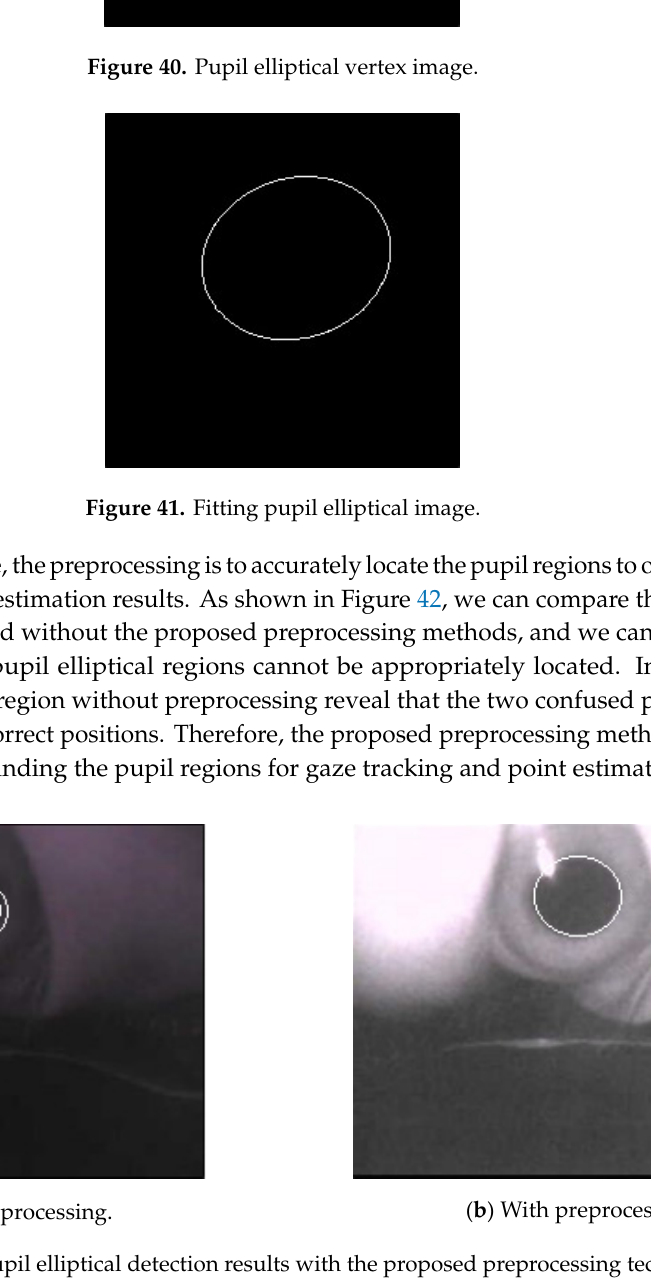
Figure 42. The pupil elliptical detection results with the proposed preprocessing techniques.